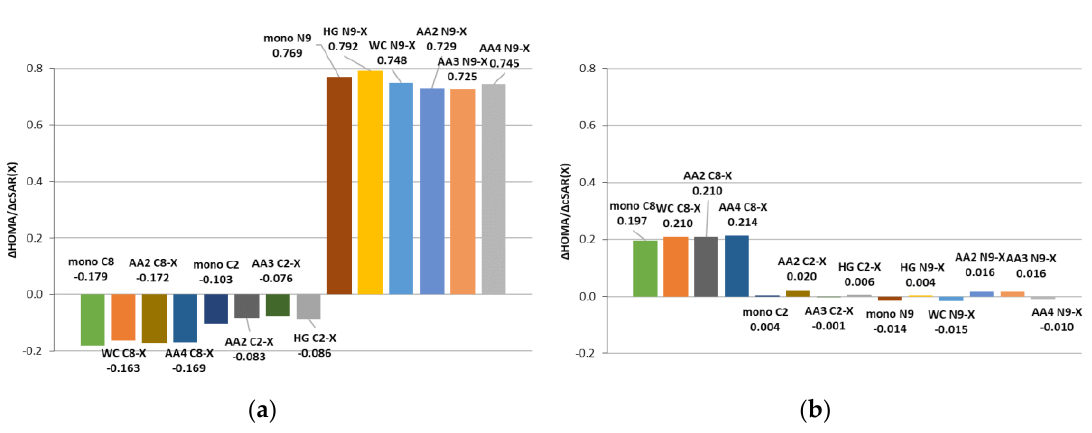
Figure 6. Reverse substituent effect in the X-R-Y system.